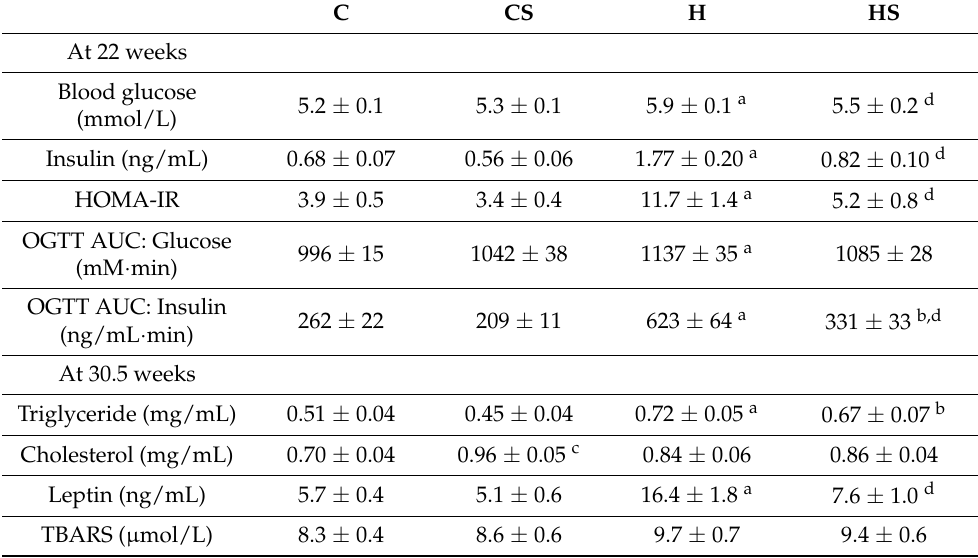
Table 3. Plasma biochemical